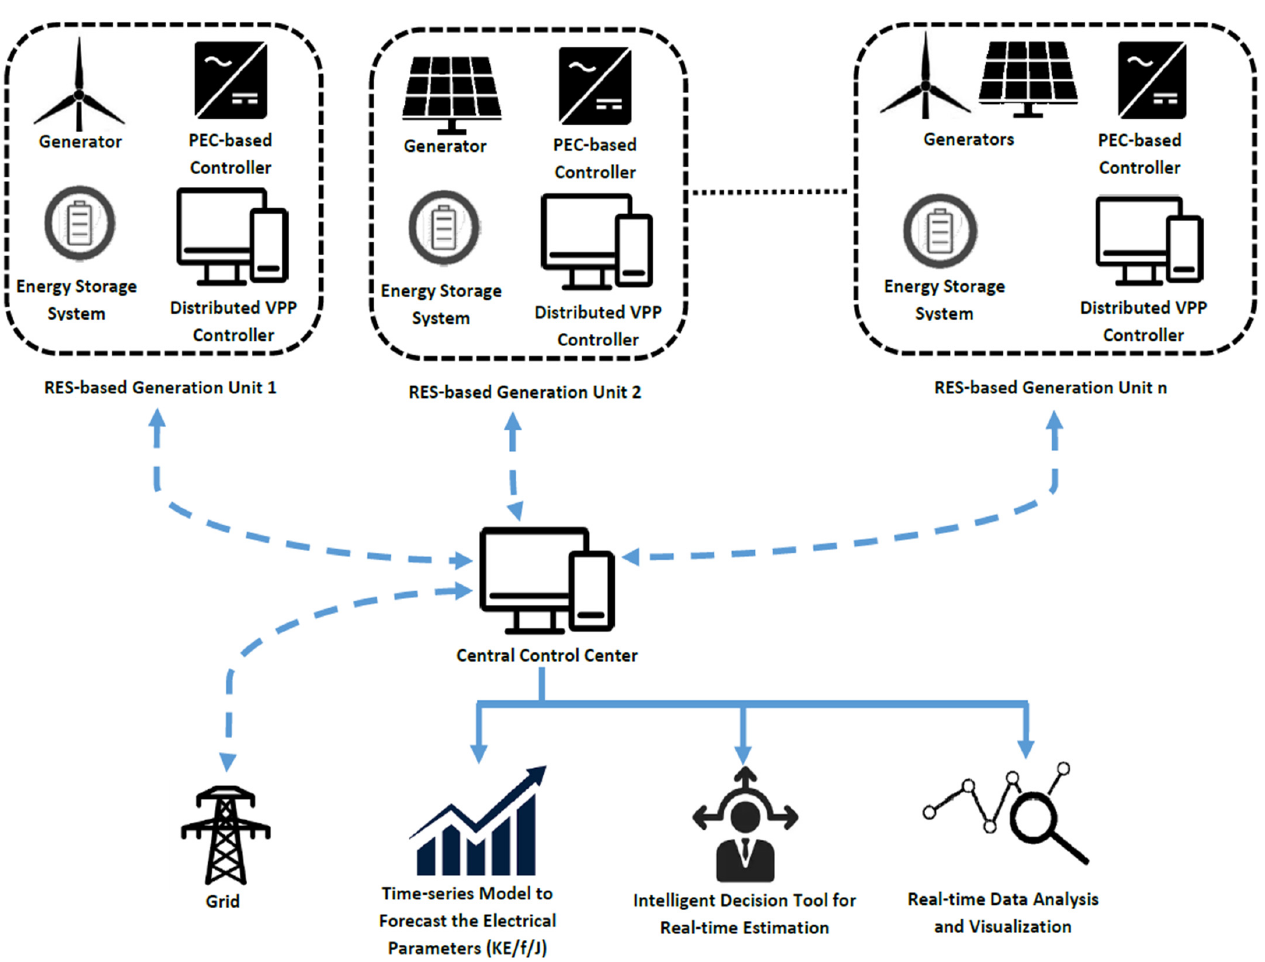
Figure 12. System overview of architecture with intelligent optimization and decision-making model.